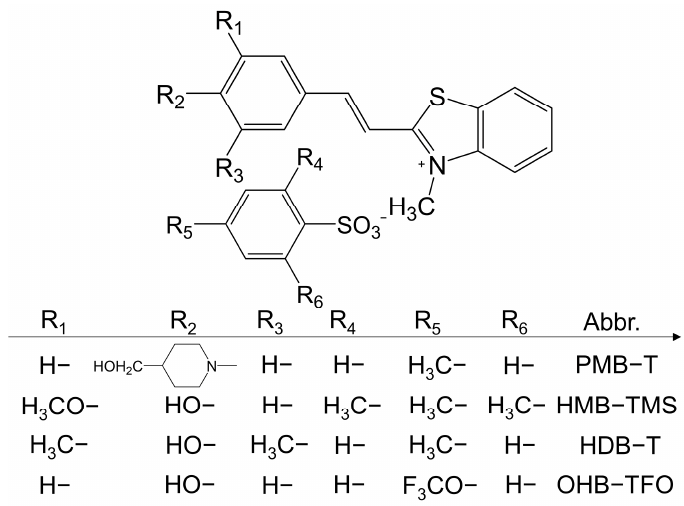
Figure 8. Chemical structures of benzothiazolium-based NLO crystals. The maximum absorption wavelength of PFB (Figure 9, Table 3) chromophore in methanol is 533 nm, which is slightly higher than that of nonfluorinated benzothiazolium- based chromophore PMB (523 nm) [50].